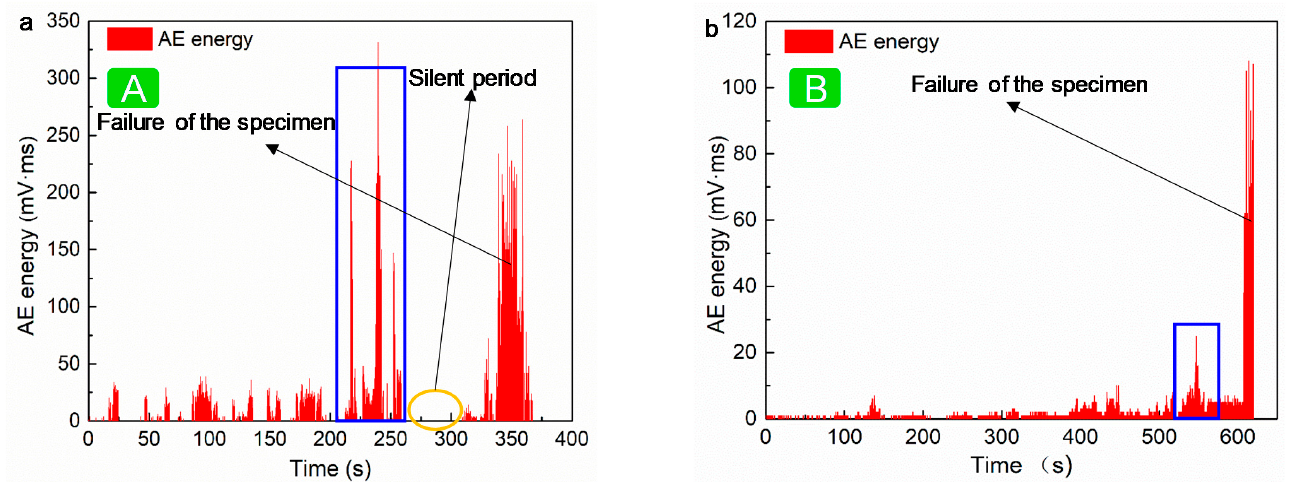
Figure 10. Temporal evolution law of AE energy on the process coal specimen’s failure. ( a ) specimen A, ( b ) specimen B.